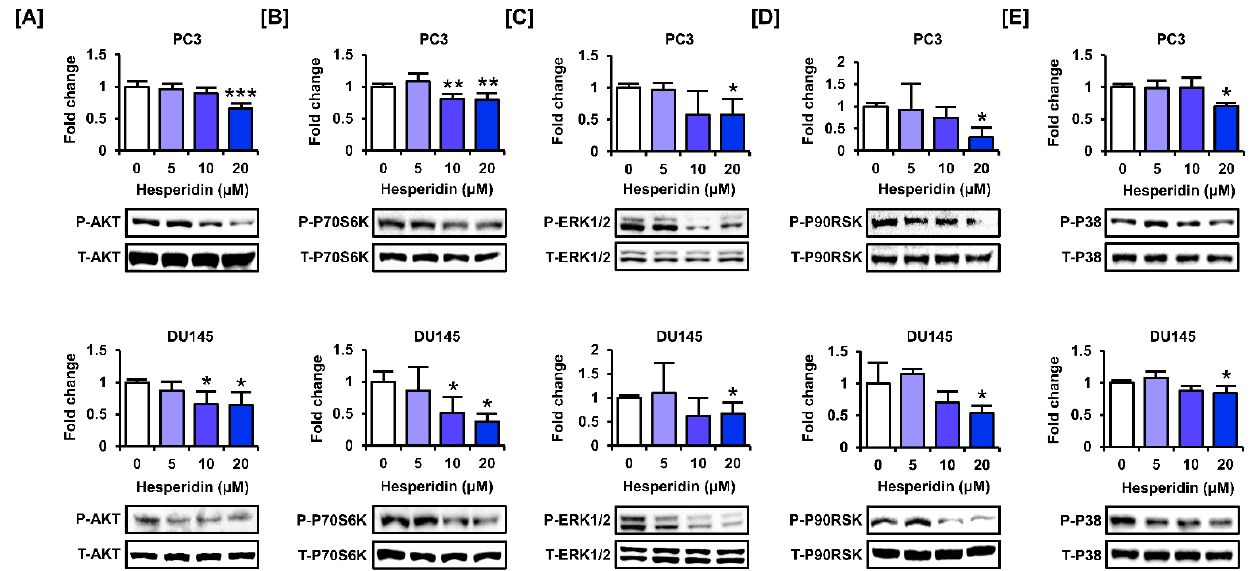
Figure 6. Effect of hesperidin on the expression levels of proteins involved in the phosphoinositide 3-kinase (PI3K) and mitogen-activated protein kinase (MAPK) pathways in prostate cancer cells. ( A – E ) Expression levels of serine-threonine kinase (AKT) ( A ), P70S6K ( B ), extracellular signal-regulated kinase (ERK)-1/2 ( C ), P90RSK ( D ), and P38 ( E ) in PC3 and DU145 cells following hesperidin treatment were determined via immunoblotting. All results of the arithmetic mean ( n = 3) denote statistical significance with asterisks (* p < 0.05, ** p < 0.01, and *** p < 0.001).